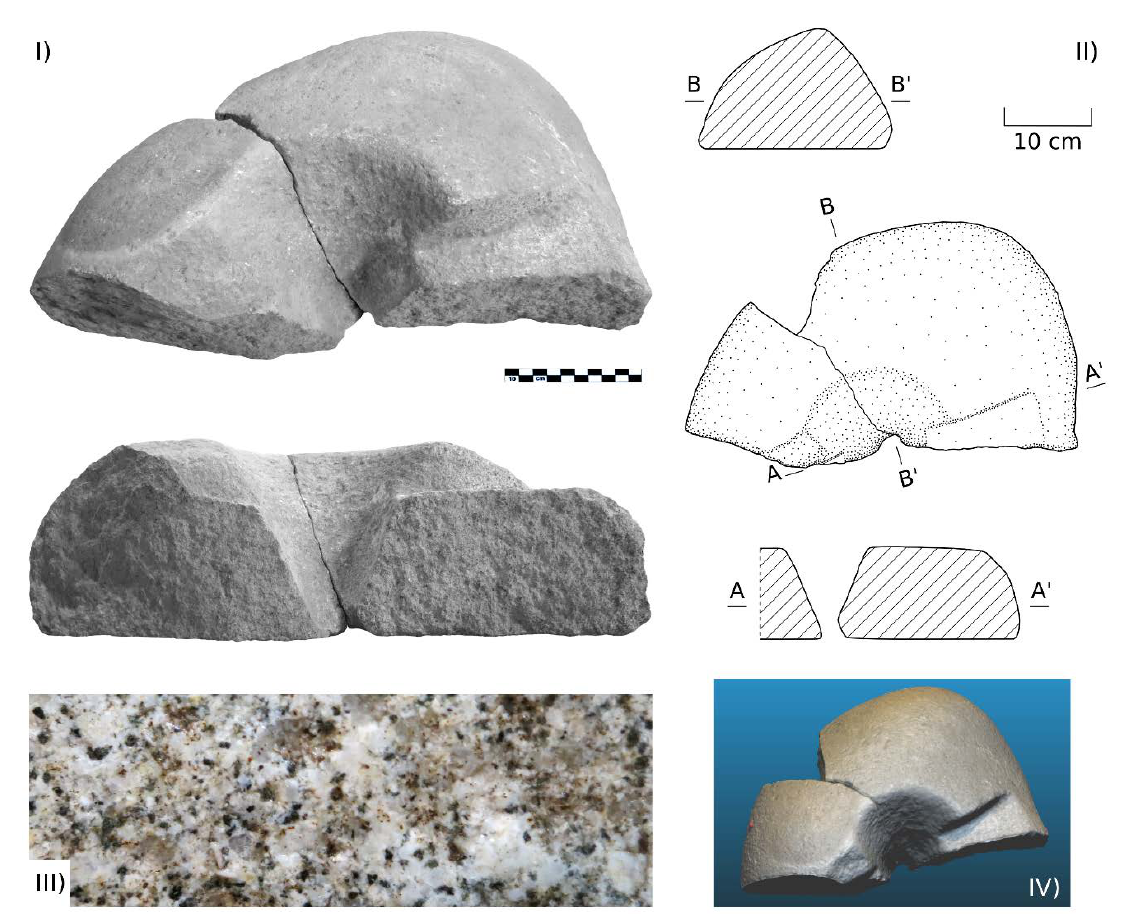
Figure 4. The Olynthus mill from San Donato (municipality of Lamón). I) Pictures (Courtesy of the Ministry of Cultural Heritage and Activities and Tourism; all rights reserved); II) Plan and section drawings; III) Detail of the granite; IV) 3D model (according to the method described in my post: Francisci